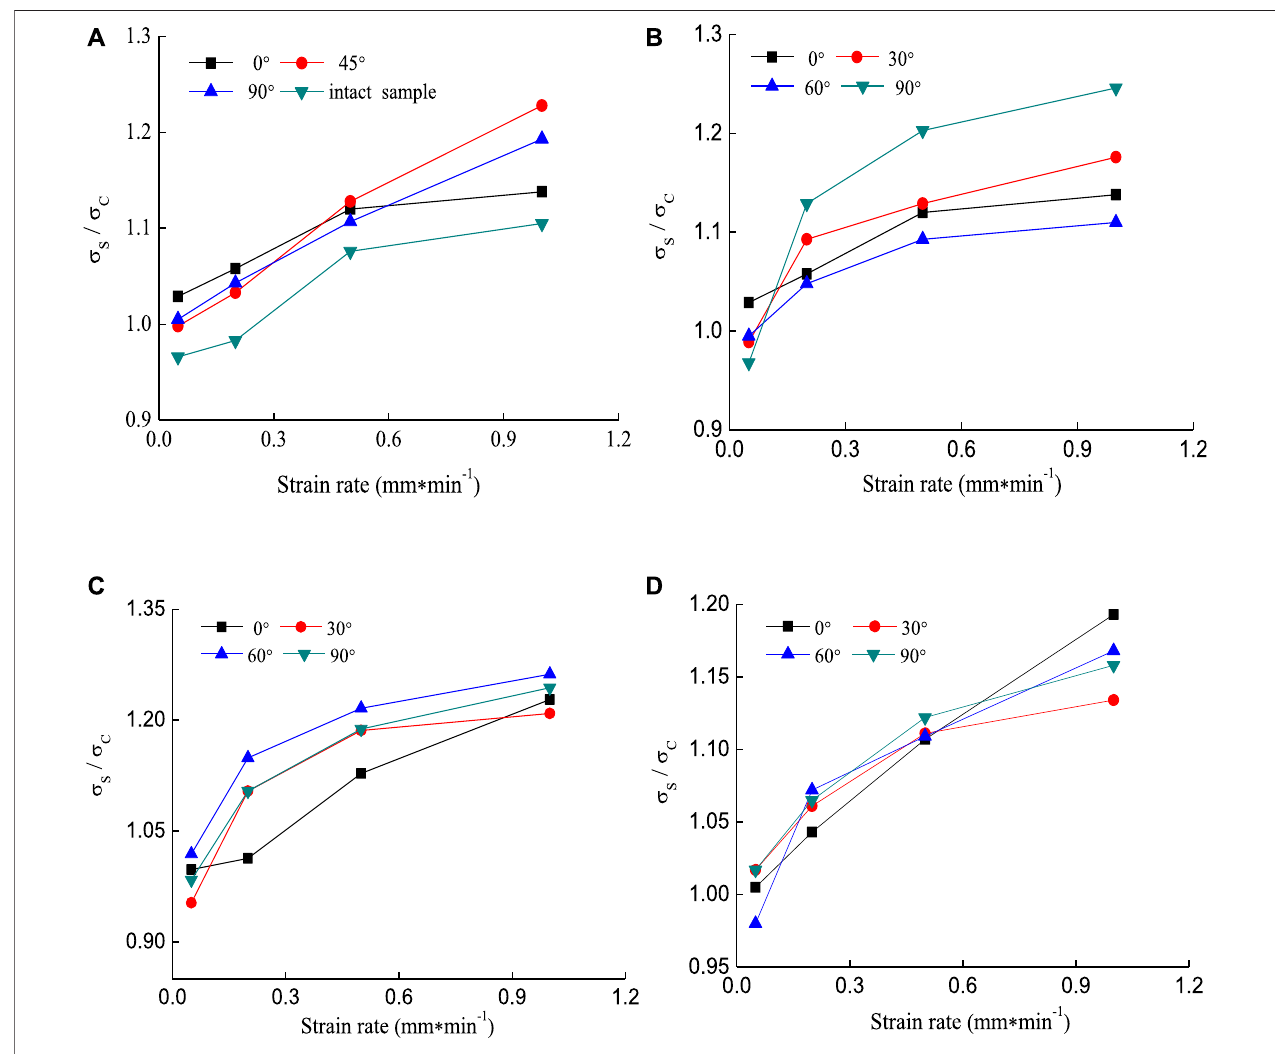
FIGURE 9 | The relationship between the ratio of dynamic strength to static strength and the strain rate, (A) Single crack samples with different inclination angles, (B) T-shaped crack samples containing the major fi ssure inclination angle of 0 ° , (C) T-shaped crack samples containing the major fi ssure inclination angle of 45 ° , (D) T-shaped crack samples containing the major fi ssure inclination angle of 90 °